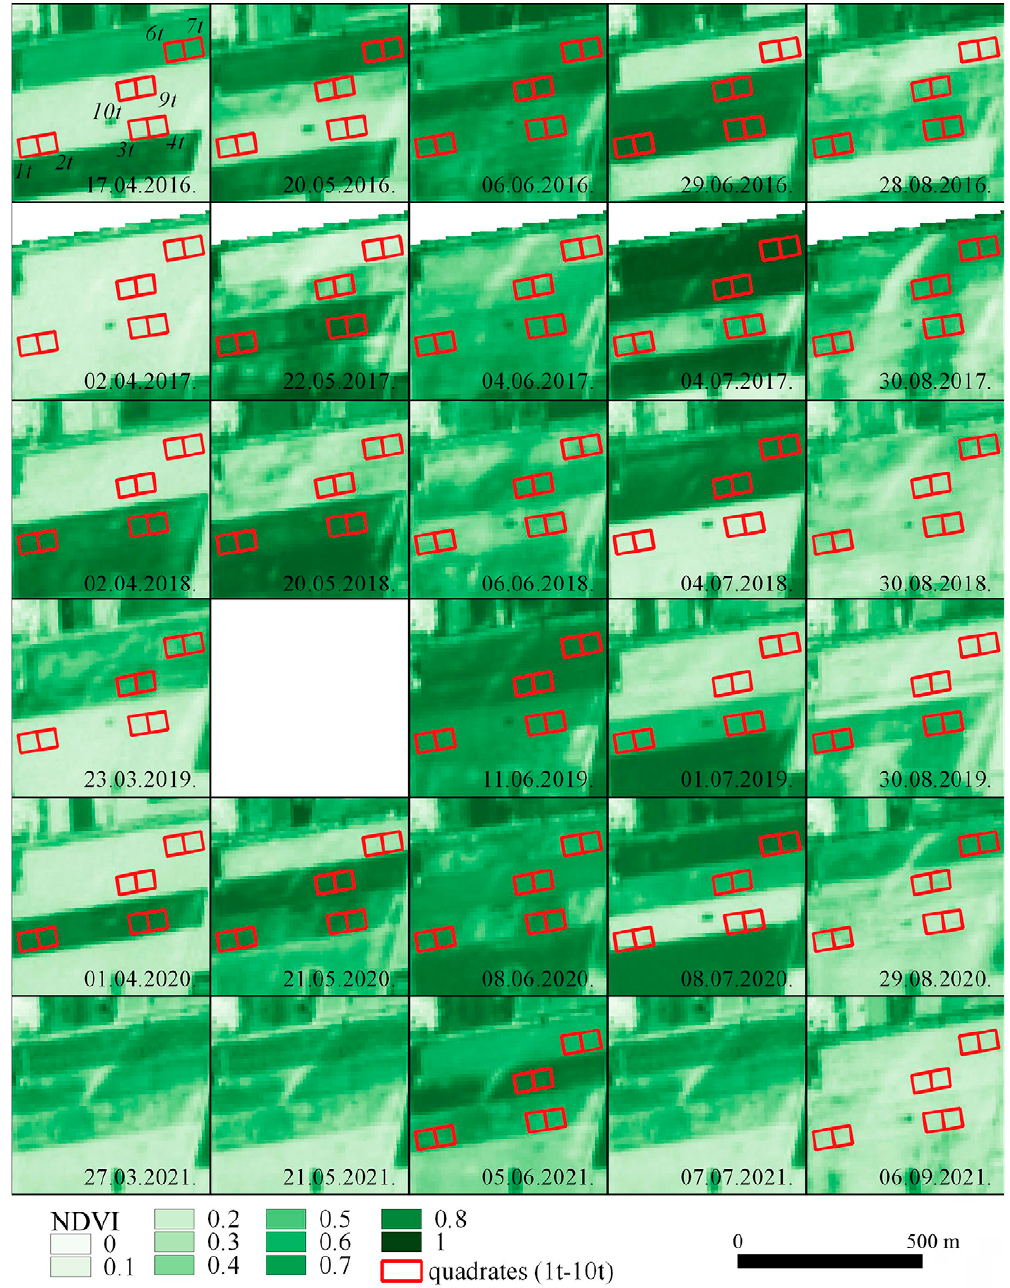
Figure 9. Spatial distribution of agricultural biomass production in the same summer periods of different